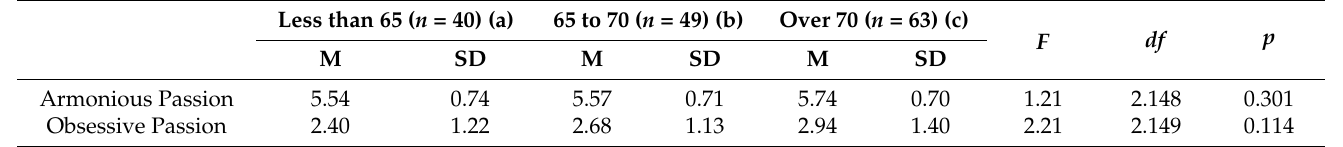
Table 10. Summary of the ANOVA of one factor: DMP considering